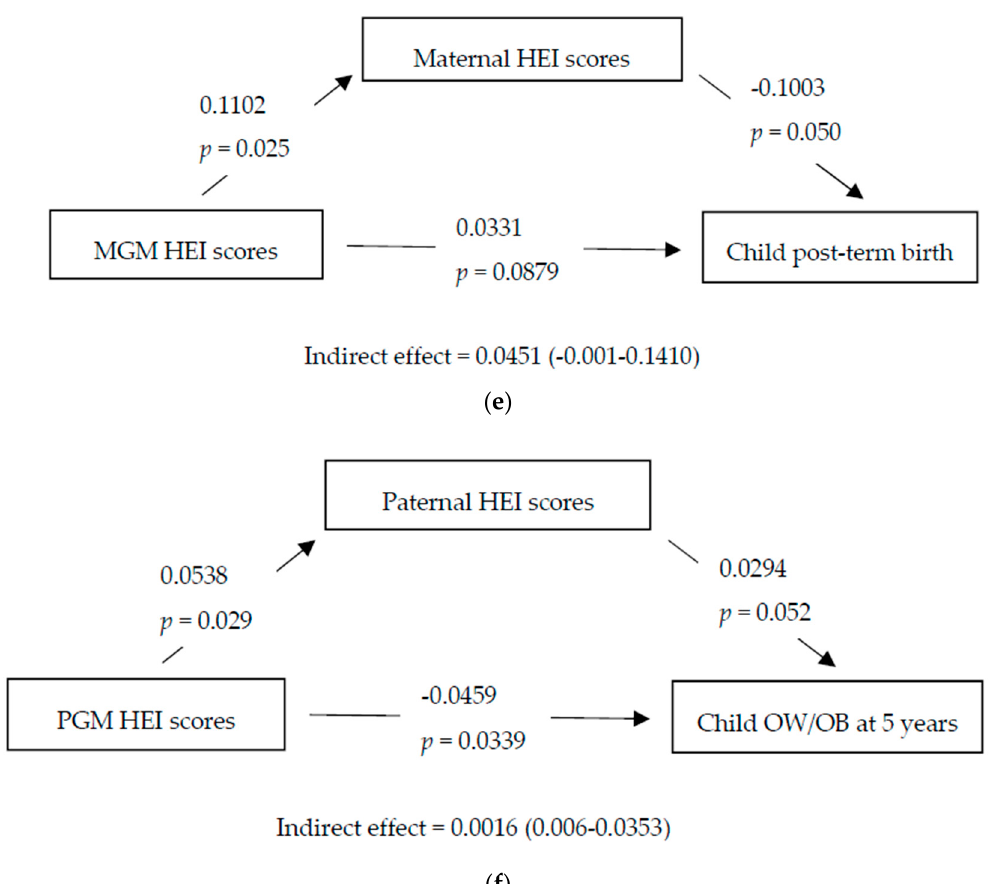
Figure 1. Mediation analysis of grandparental HEI scores on grandchild outcome through parental